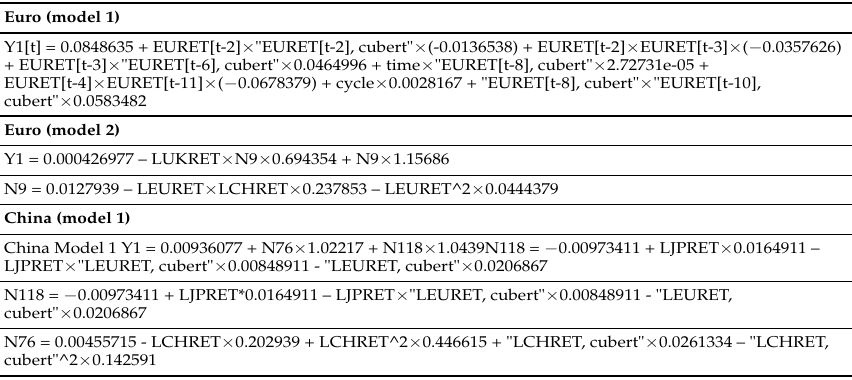
Table 8. Neural Network Regression